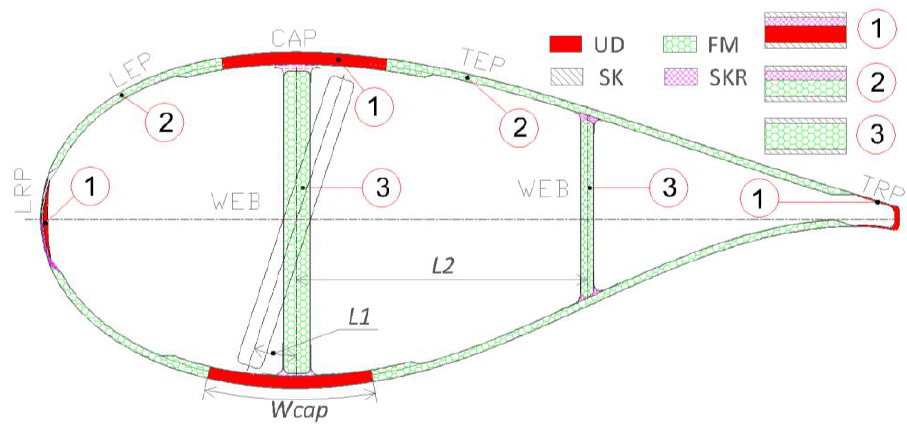
Figure 8. Typical structural configuration of a blade cross-section.